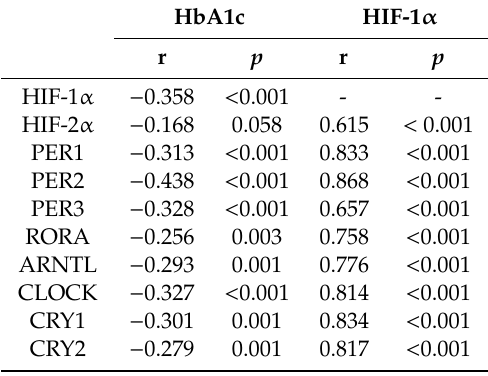
Table 2. Linear correlations between the expression of the 8 clock genes assessed in our study and glycated hemoglobin and HIF-1 α gene expression.